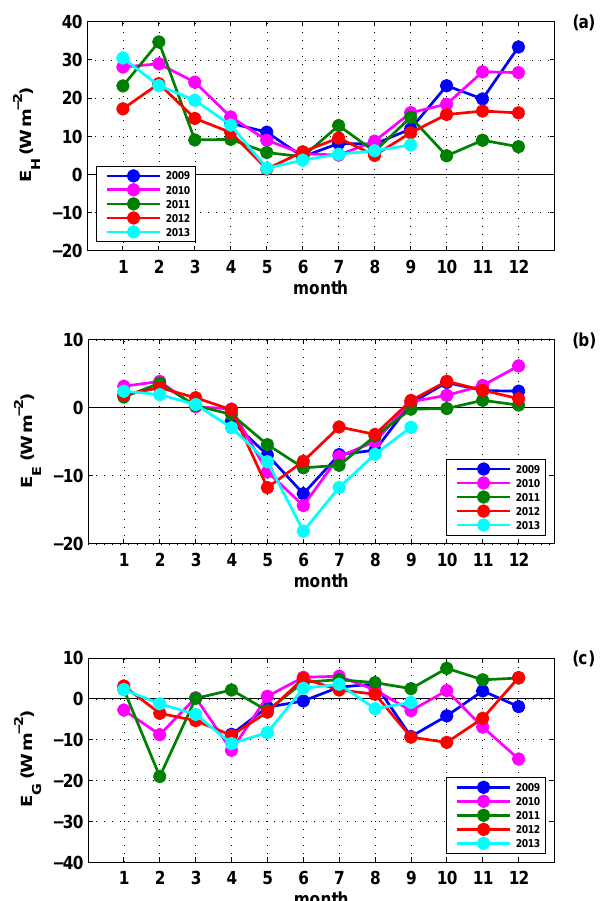
Figure 7. Seasonal cycles for the years 2009–2013 based on monthly averages of (a) sensible heat flux, (b) latent heat flux, and (c) subsurface heat flux.